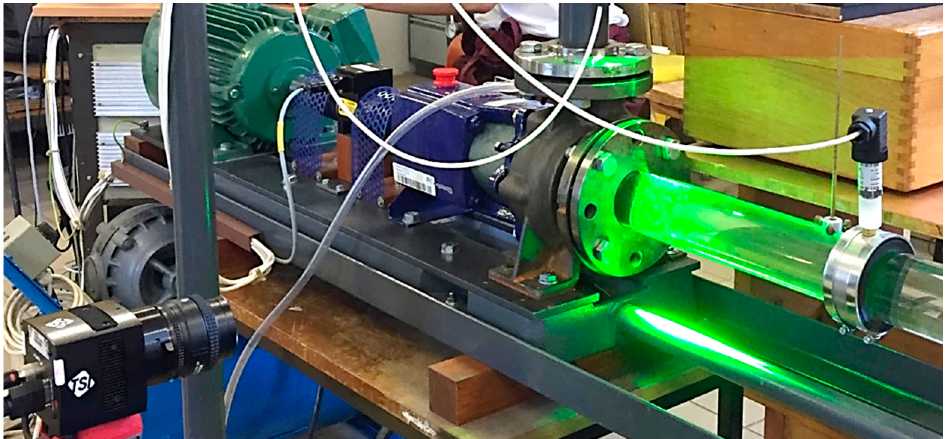
Figure 2. PIV method application during the experiment [22].